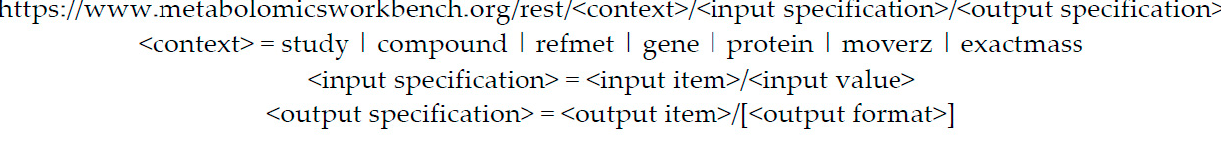
Figure 6. Pattern for crafting HTTPS requestable URLs to interface with the Metabolomics Workbench REST interface.